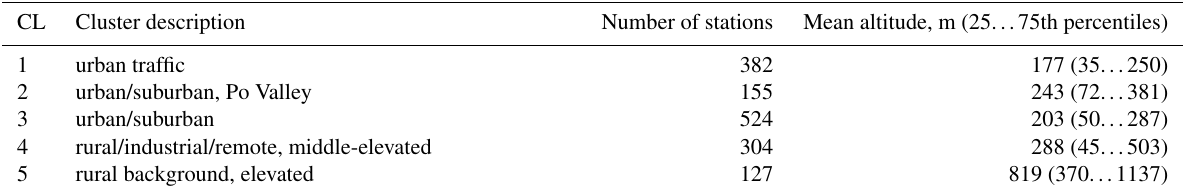
Table 2. Cluster statistics and description based on the Airbase classification, geographical location, and altitude range of clusters; first CA. CL Cluster description Number of stations